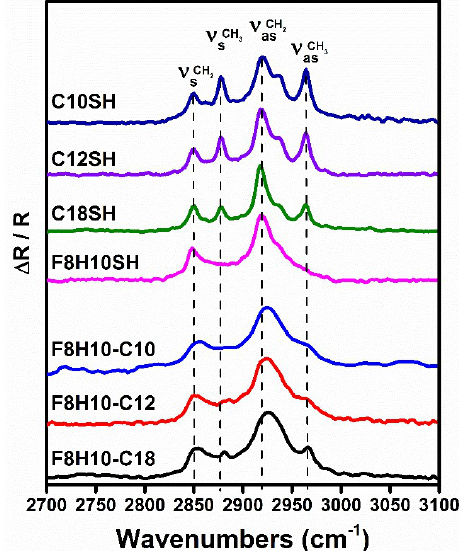
Figure 5. Polarization modulation-infrared reflection-adsorption spectroscopy (PM-IRRAS) spectra in the C-H stretching region for SAMs generated from the alkanethiols, F8H10SH , and the F8H10-Cm adsorbates used in this study.